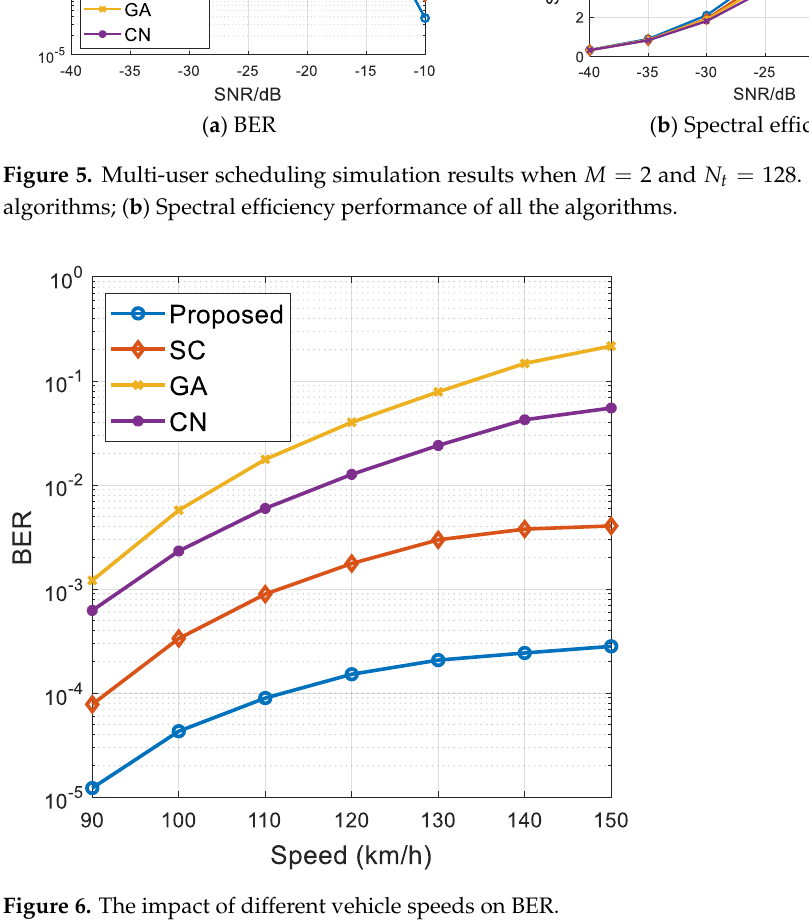
Figure 6. The impact of different vehicle speeds on BER.